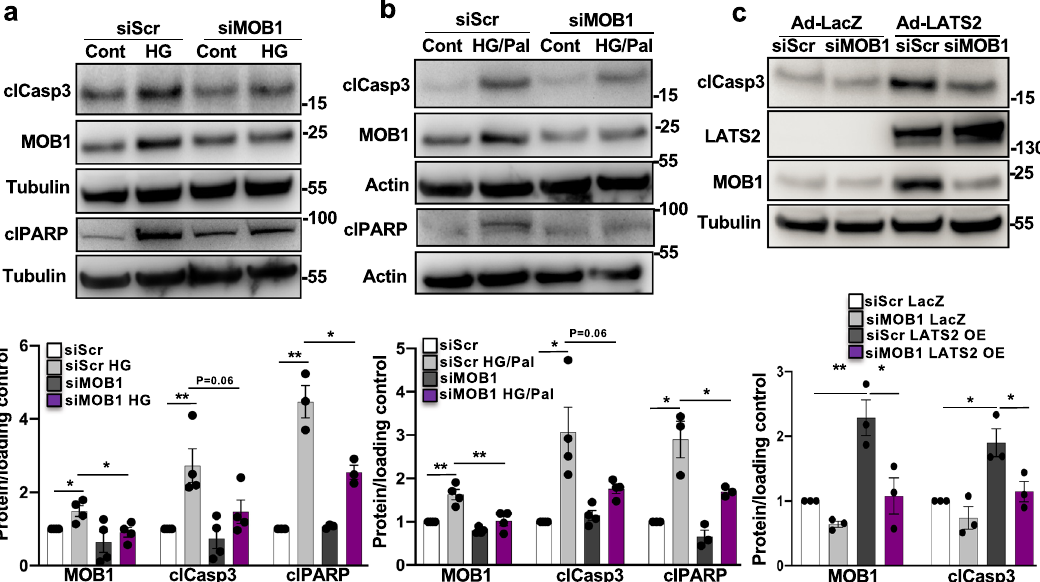
Fig. 4 MOB1 knockdown protects from β -cell apoptosis in vitro. a , b Representative western blots and pooled quantitative densitometry analysis (lower panels) of INS-1E cells transfected with siMOB1 or control siScr and treated with a 22.2 mM glucose or b 22.2 mM glucose plus 0.5 mM palmitate for 48 h ( n = 4 independent experiments; n = 3 for clPARP). c Representative western blot and pooled quantitative densitometry analysis (lower panel) of INS-1E cells transfected with siMOB1 or siScr and transduced with Ad-LacZ or Ad-LATS2 for 48 h ( n = 3 independent experiments). Results were normalized to the respective control conditions and ratios, in which a normal distribution of results cannot be proven, were analyzed. Data are expressed as means ± SEM. * p < 0.05, ** p < 0.01; all by two-tailed Student ’ s t-